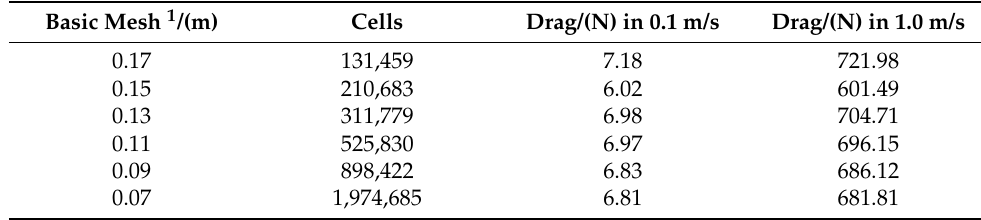
Table 2. The mesh irrelevance